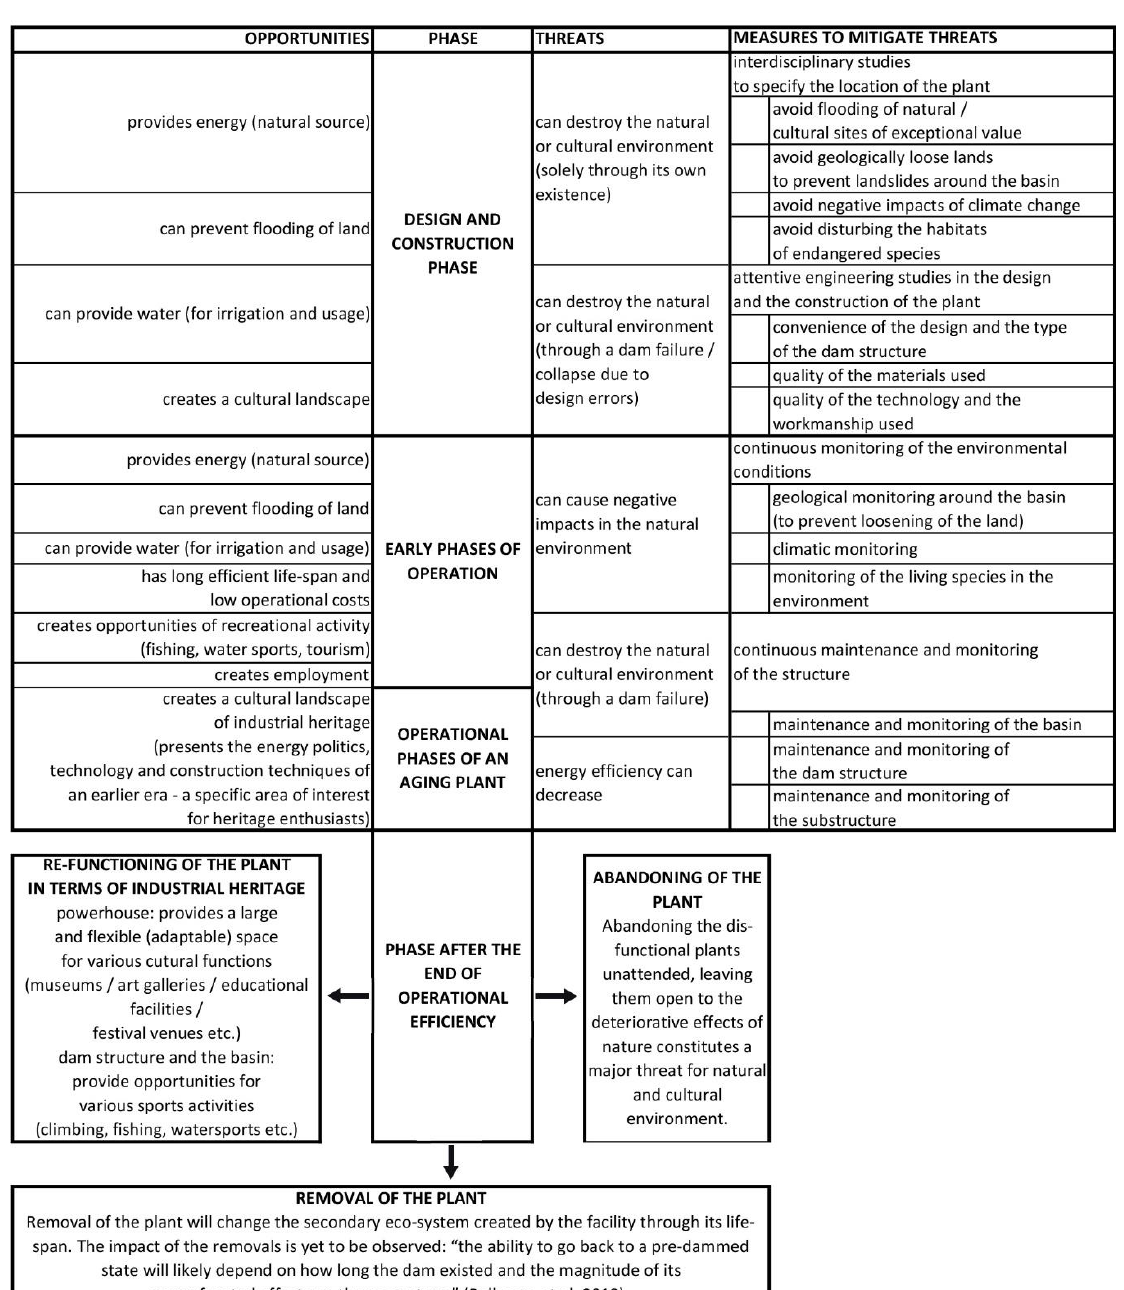
Figure 11. Flowchart throughout the lifespan of hydroelectric plants their interactions with cultural and natural environments, including opportunities, threats, and measures for the mitigation of threats.